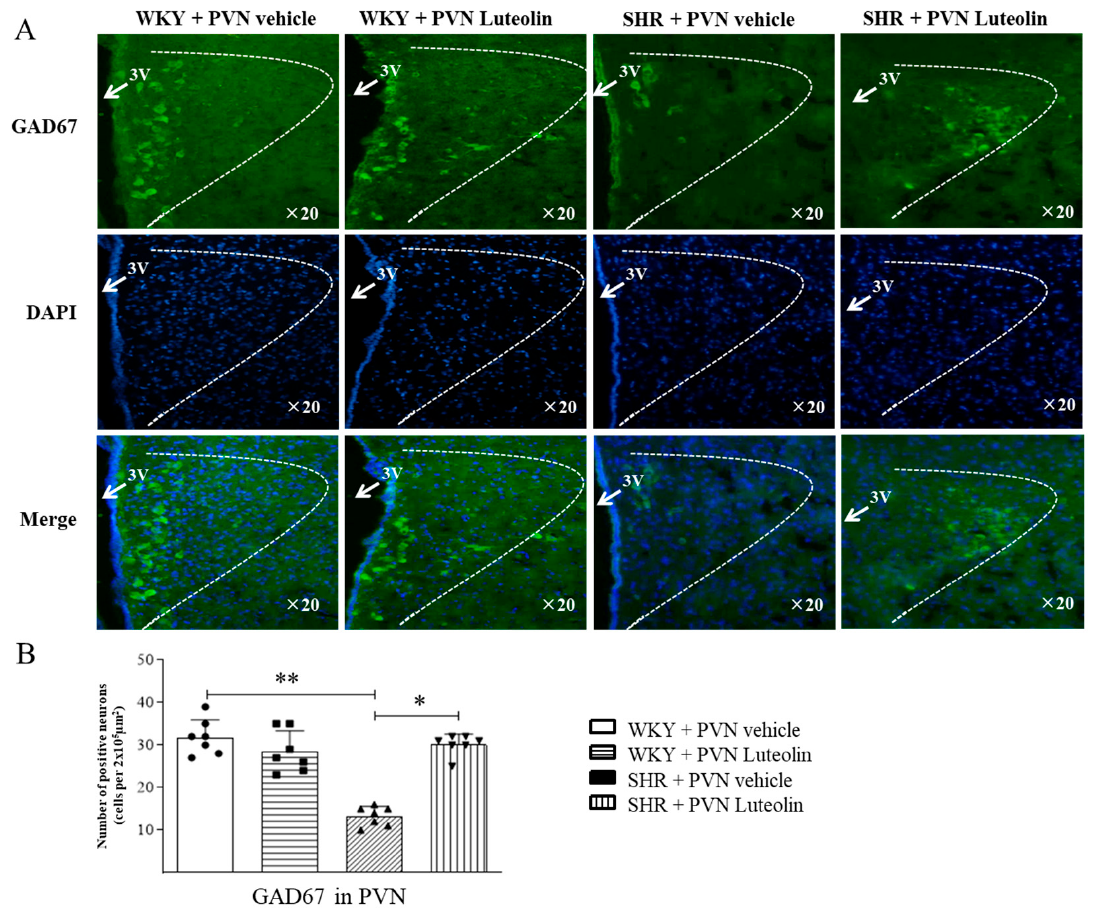
Figure 7. Effects of PVN luteolin on GAD67 in PVN. ( A ) A representative immunomicrographs showing GAD67 positive cell (green fluorescence). ( B ) Statistical quantification of GAD67 positive cells in PVN of SHRs and WKY rats, with or without luteolin treatment. Values are the mean ± SEM from 7 rats/group. * p < 0.05, ** p < 0.01. 3V, third ventricle .